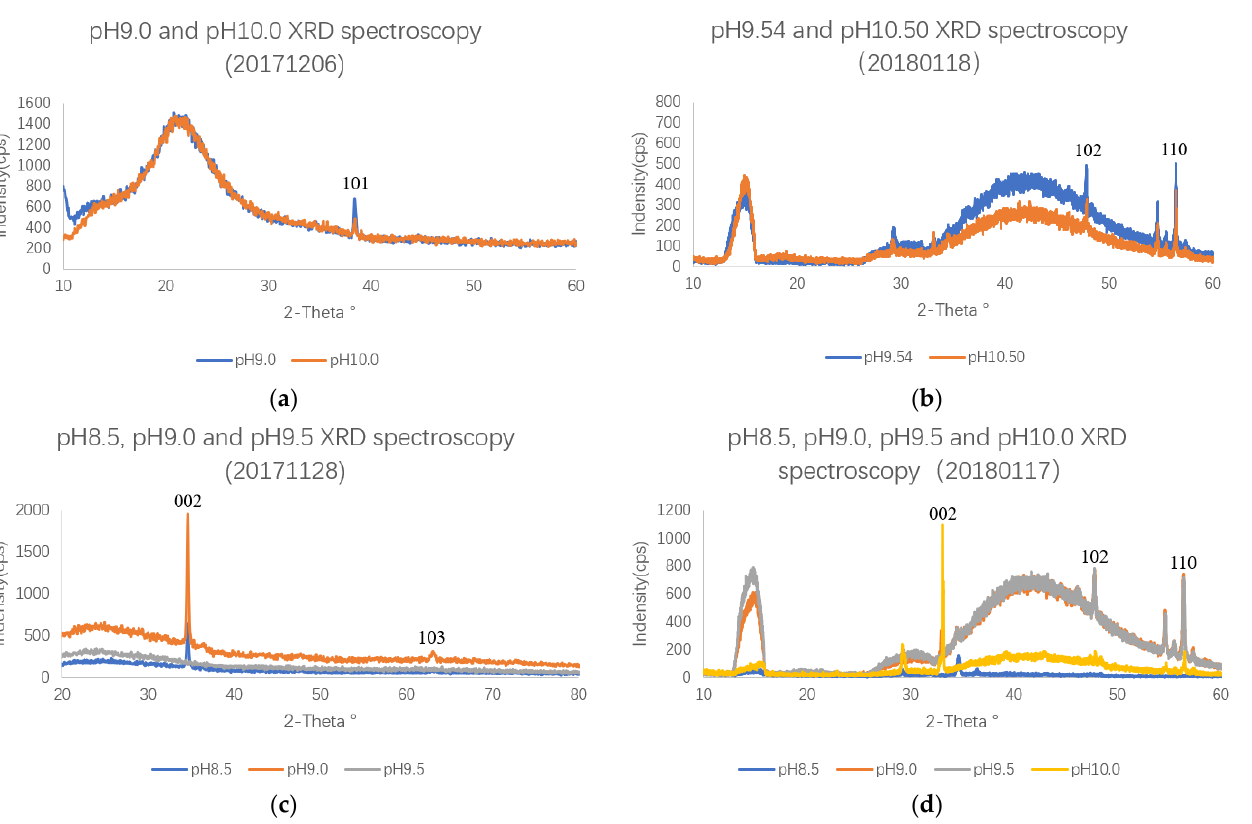
Figure 1. ZnO XRD data for different HCD time. ( a ): ZnO (made by 1 h HCD) XRD data. ( b ): ZnO (made by 2 h HCD) XRD data. ( c ): ZnO (made by 4 h HCD) XRD data. ( d ): ZnO (made by 6 h HCD) XRD data.